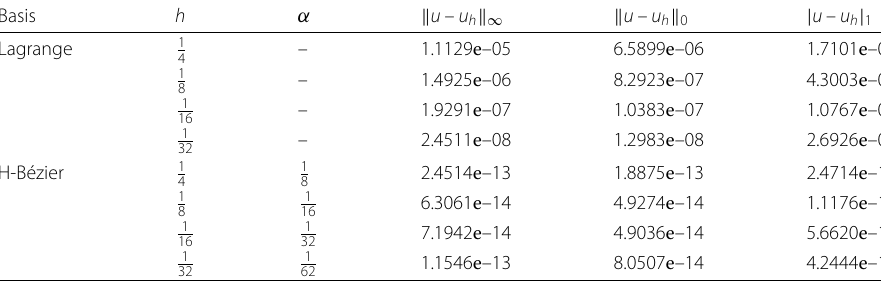
Table 4 The numerical